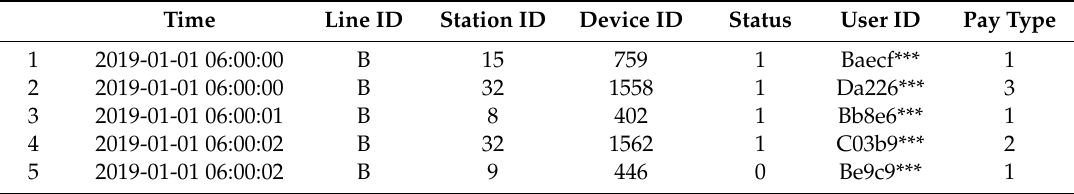
Table 2. Some samples of the collected data.